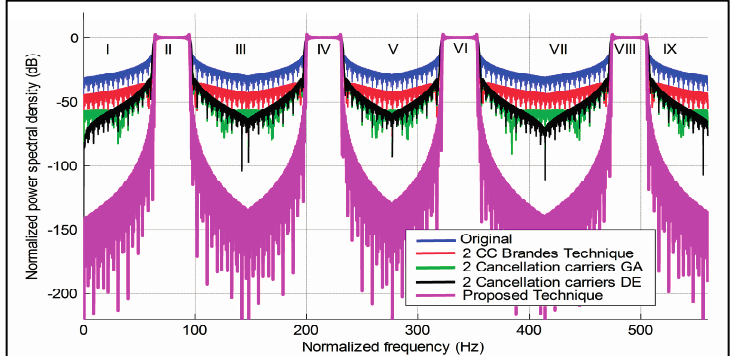
Figure 10. The PSD comparison between the proposed technique and existing techniques including ACC and ASW.